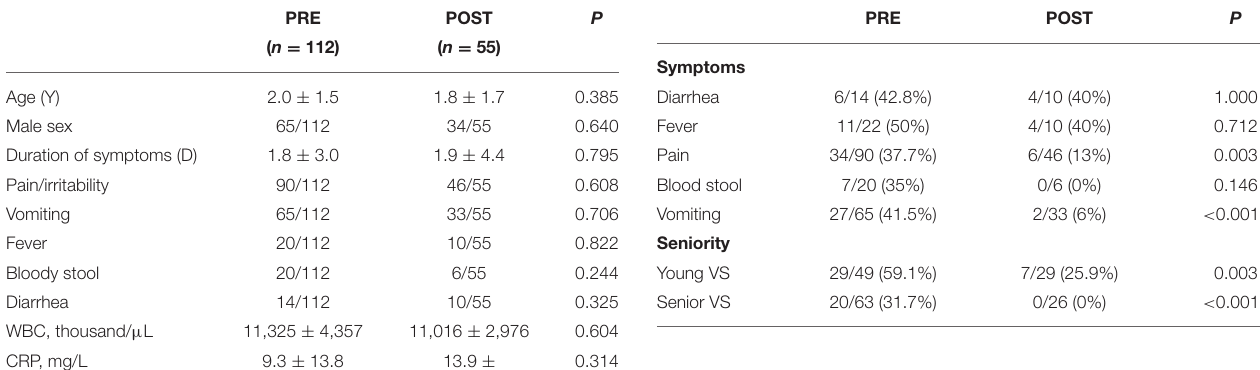
TABLE 3 | Comparison of misdiagnosis associated clinical symptoms and seniority of attending (VS) between the PRE and POST groups. PRE